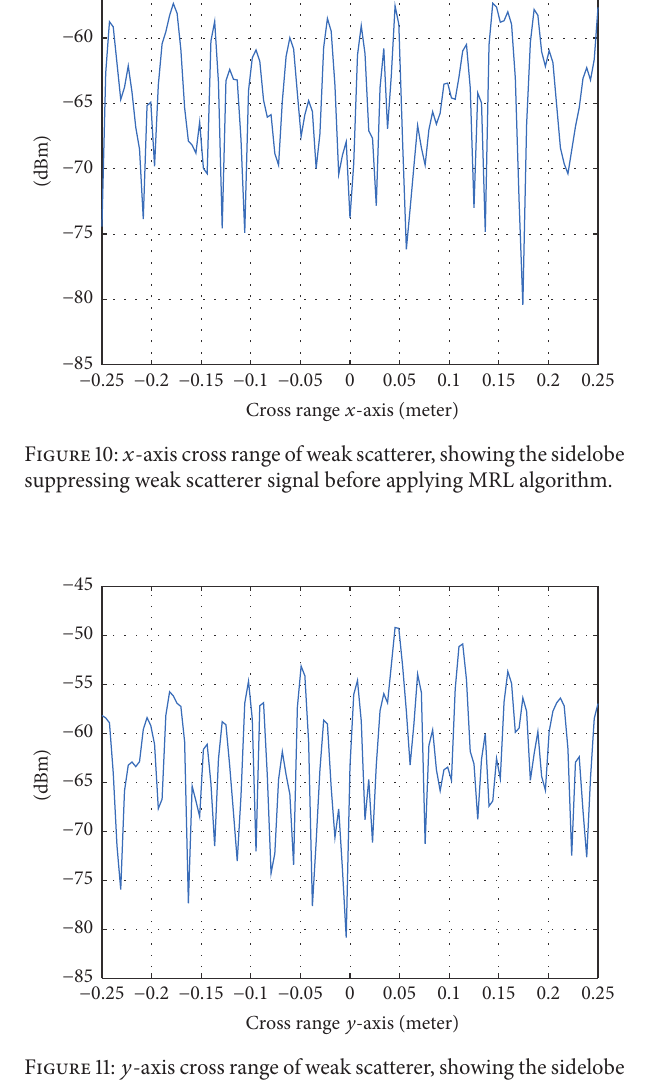
Figure 11: 𝑦 -axis cross range of weak scatterer, showing the sidelobe suppressing weak scatterer signal before applying MRL algorithm.